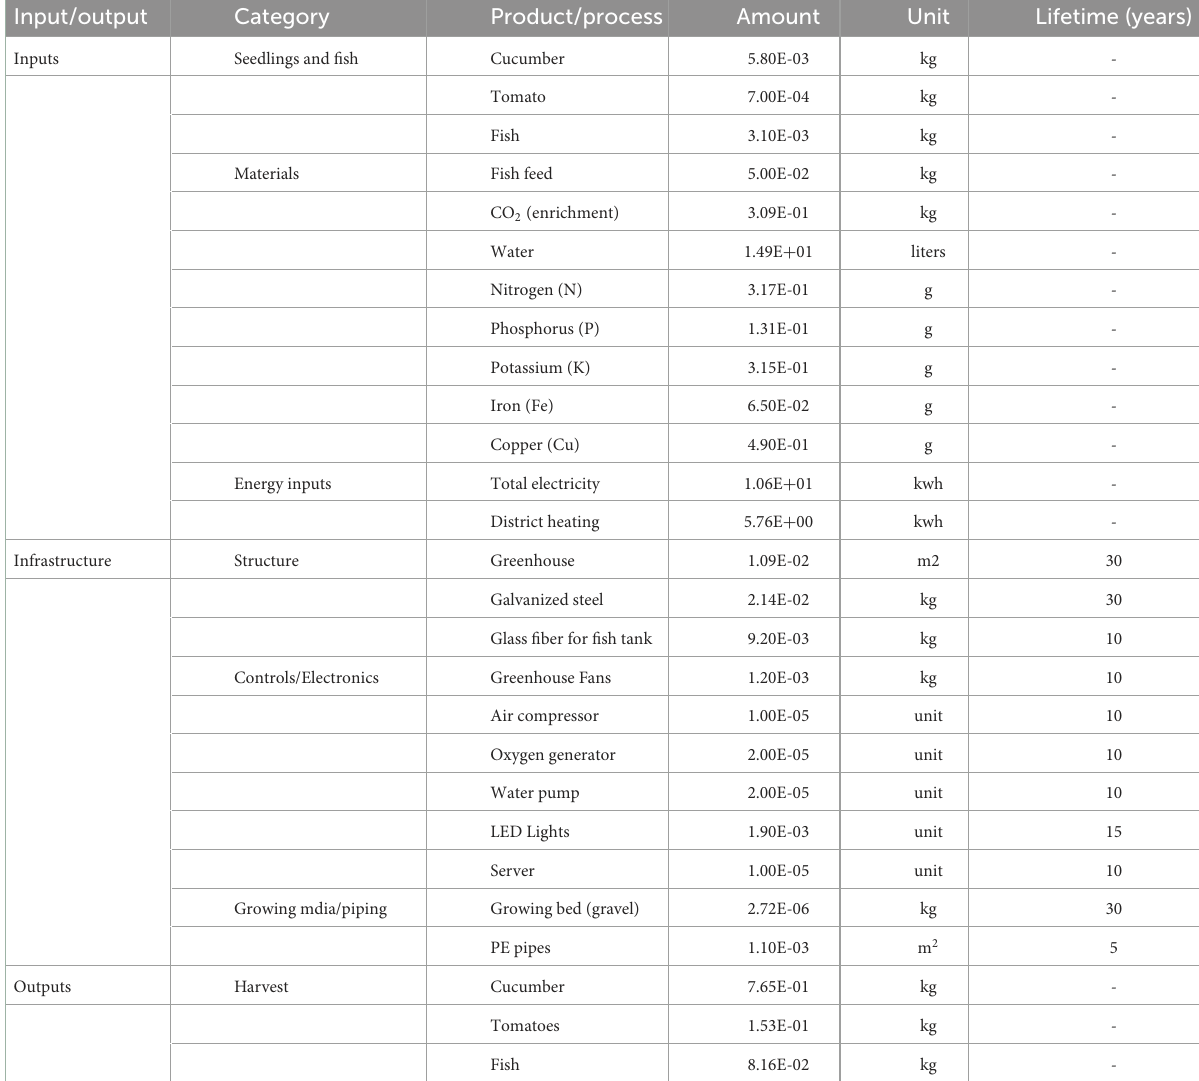
TABLE 2 Inventory data based on 1kg